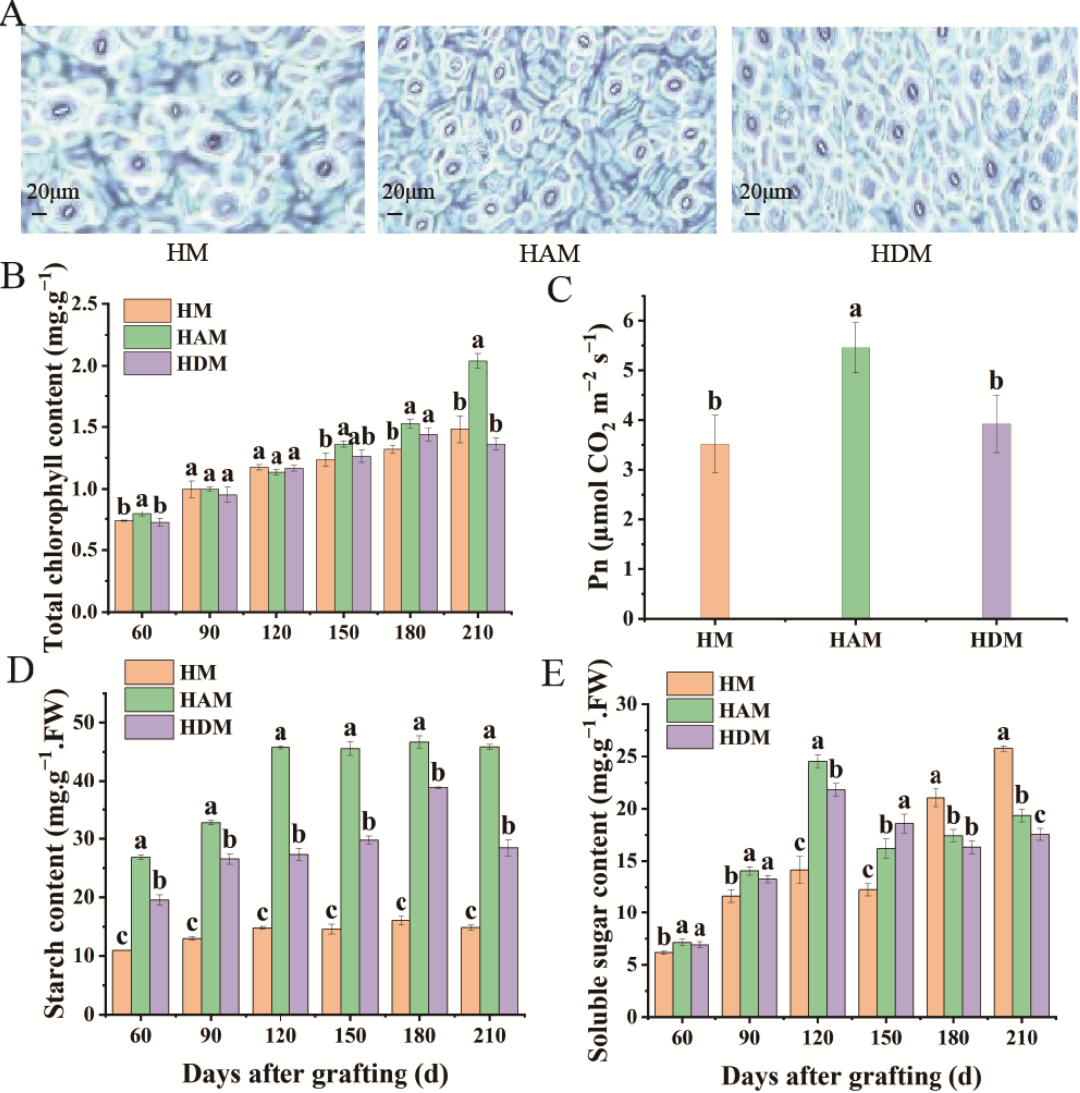
Figure 2. Effect of different interstocks on photosynthetic related physiological indicators of grafted ‘Mingrijian’ seedlings leaves. ( A ) Microscopy of stoma from plants after 210 days, ( B ) total chlorophyll, ( C ) Pn, ( D ) starch content and ( E ) soluble sugar content. Data were the mean ± standard error of three replicates. Error bars indicate the standard error, and different letters indicate significant differences, p < 0.05.